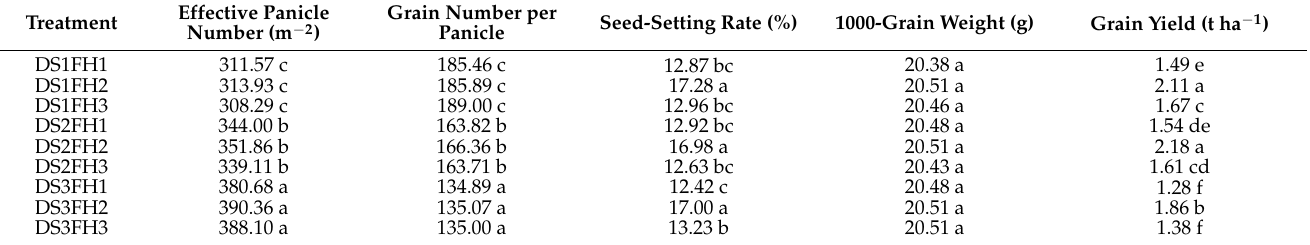
Table 1. Effects of different planting densities and flight heights on hybrid rice seed production in Xuwen.